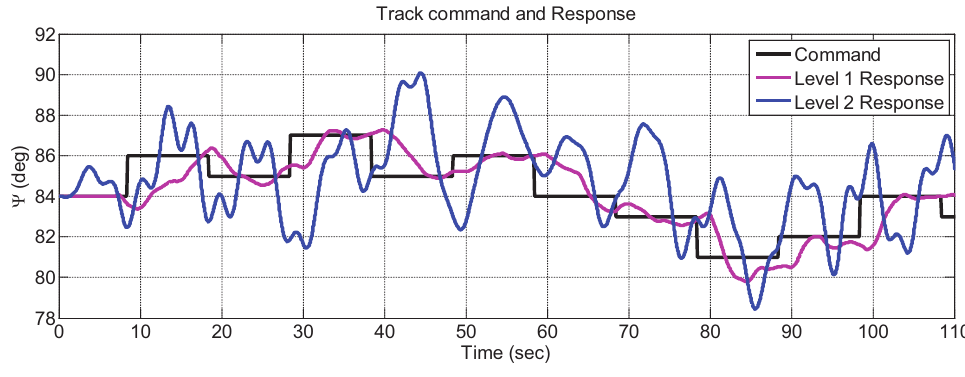
Figure 9. Pilot tracking the heading